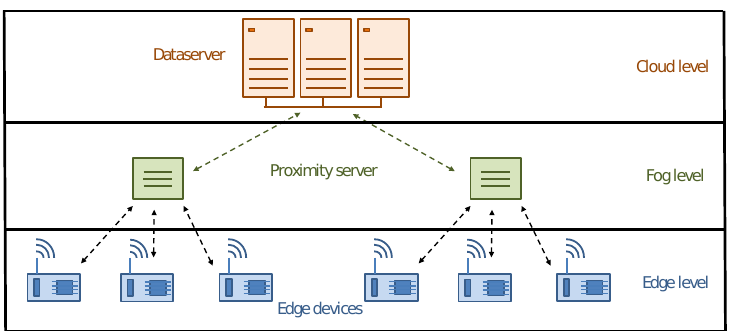
Figure 1. The computing